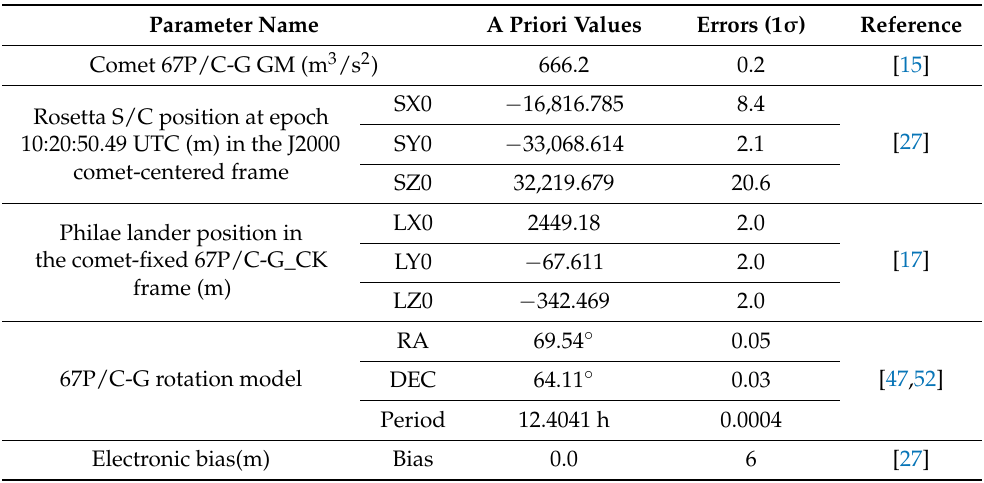
Table 6. Error budget for CONSERT direct range modelling.